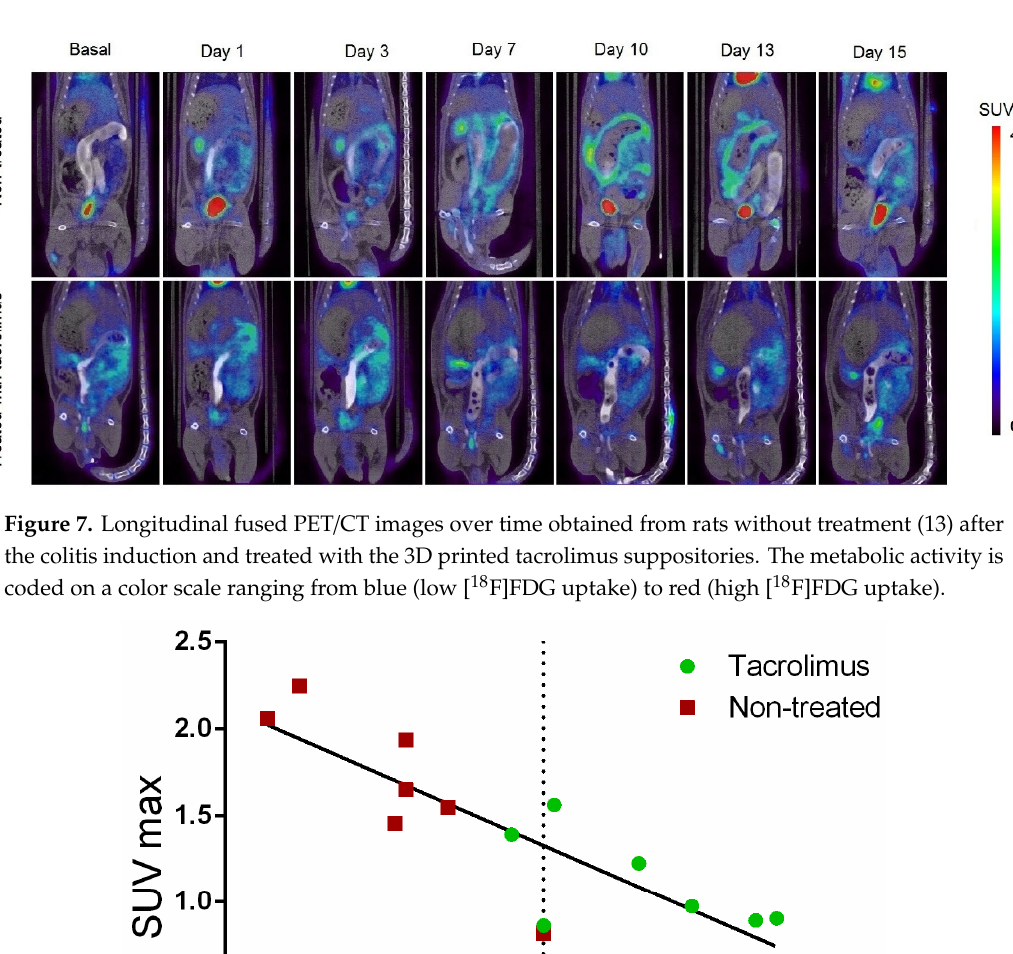
Figure 8. Correlation of average SUV max values with body weight changes from the baseline (dotted line).